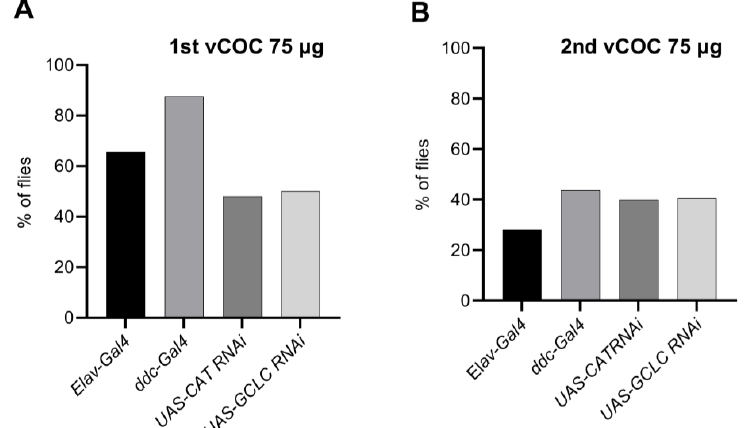
Figure A4. Main driver lines Elav -Gal4 and ddc -Gal4 and UAS-lines carrying RNAi constructs for CAT and GCLC show sensitivity and locomotor sensitization to vCOC similar to wt . ( A ) Percent of individual flies that increased locomotor activity relative to baseline activity after single exposure